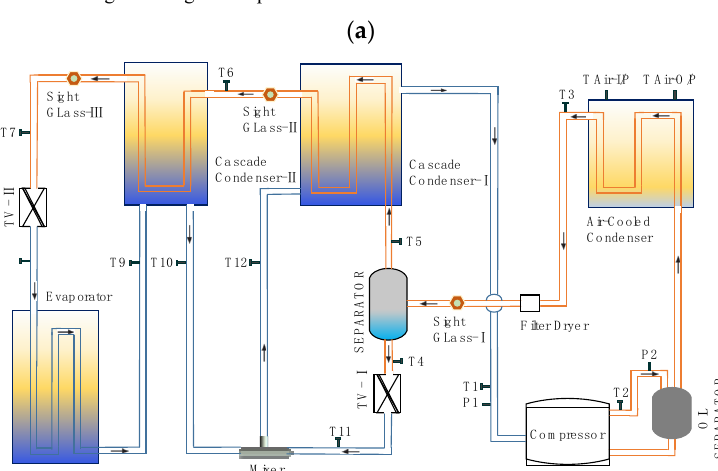
Figure 1. ( a ) The schematic diagram of the ACRC; ( b ) The schematic diagram of the MACRC. To analyze the thermodynamic properties of MACRC at different freezing tempera- tures, the given variable working condition is the evaporation temperature T e within the range of − 70 ◦ C to − 65 ◦ C. For the selection from HCs, the refrigerant R170, which has a lower triple phase point and a lower NBP than T e , was chosen as the refrigerant for the low temperatures [29]. The refrigerant R600a, commonly used as a refrigerant system, is used as the refrigerant for high temperatures. These two refrigerants together form a zeotropic mixture. However, the working pressure of R170 is very low and R170 is prone to negative evaporation in the system, which inevitably leads to ice blocks in practical applications. In addition, the low vapor pressure can cause flashing of the lubricating oil, which can lead to a loss of lubrication in the compressor, resulting in a high temperature and pressure exhaust. The refrigerant R290 can moderate the vapor pressure in the low-temperature section. A ternary zeotropic mixture of R600a/R290/R170 is used as the working fluid in this work. Some basic properties of the components are given in Table 1. These three refrigerants are flammable and classified as Class A3 in safety. It can be used in small-scale refrigeration devices with a limited refrigerant charge